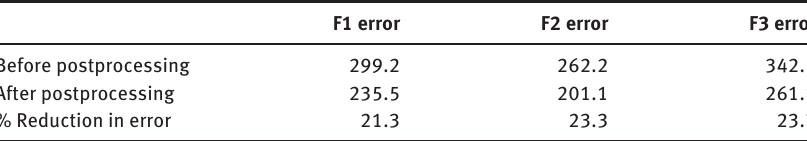
Table 2. Average Frame-Level Formant Estimation Error (Hz) for CV Syllables of the VTR Formant